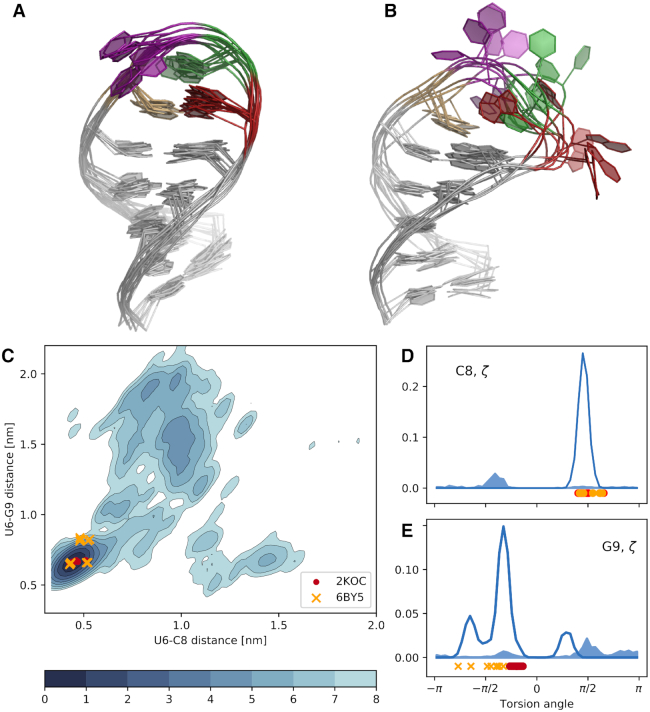
(A) Representative (random) conformations sampled from state A. (B) Representative (random) conformations sampled from state B. The color code is identical to Figure 1: U6 in ochre, U7 in purple, C8 in green and G9 in red. (C) Free energy surface projected onto the the U6-C8/U6-G9 distance between ring centres. The units of the colorbar are in kBT. (D) Histogram of ζ dihedral angle in C8. The open filled area indicates conformations belonging to state A, and the filled area indicates conformations belonging to state B. (E) Histogram of ζ dihedral angle in G9.